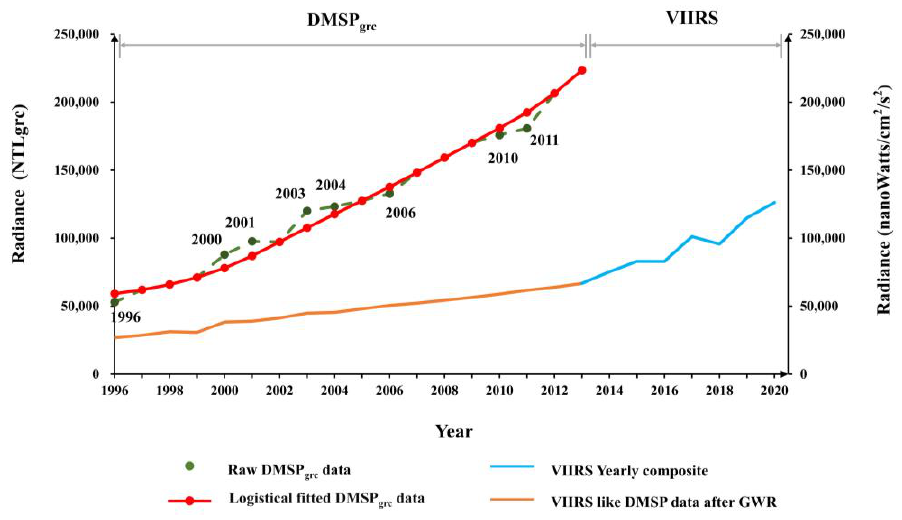
Figure 3. Schematic diagram of NTL data pre-processing.